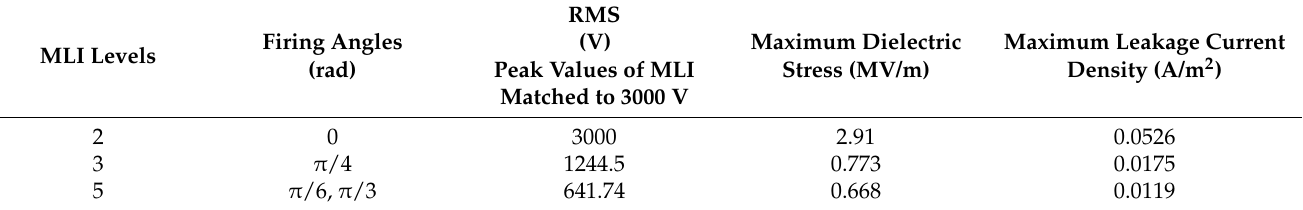
Table 4. Effect of increase in voltage levels on stator ground-wall